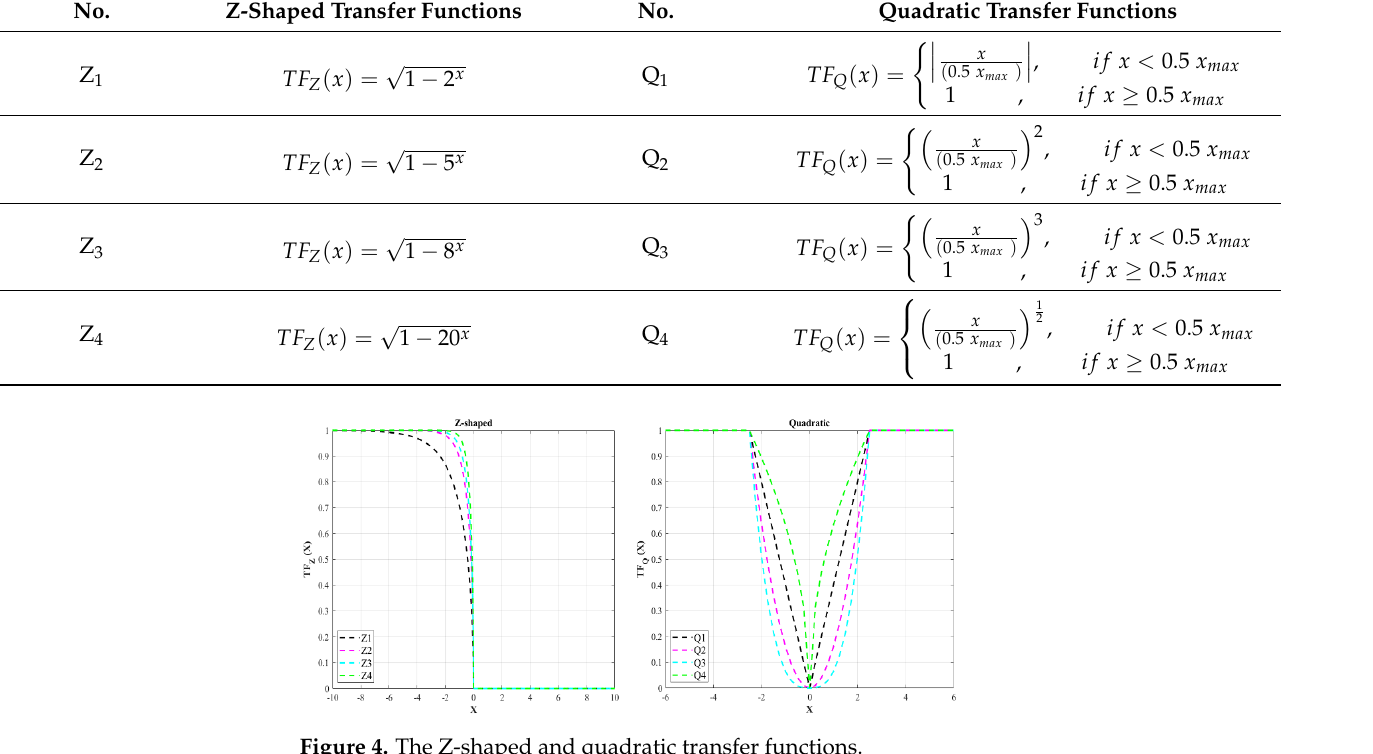
Figure 4. The Z-shaped and quadratic transfer functions. Table 2. The formulation of Z-shaped and quadratic family transfer functions.